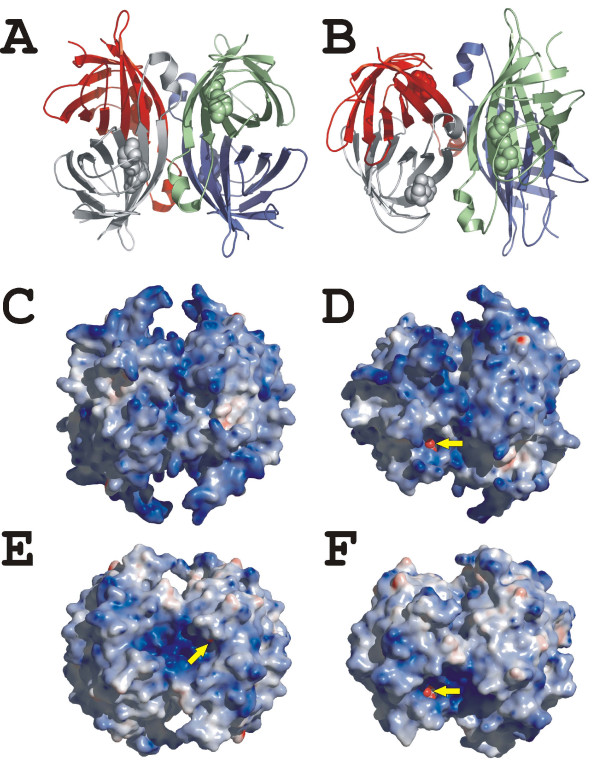
The overall X-ray structure of chicken BBP-A. (a, b) A tetrameric ribbon model of the BBP-A – BSO structure. (c, d) Electrostatic potentials mapped onto the molecular surface of the BBP-A – BSO structure. (e, f) Electrostatic potentials mapped onto the molecular surface of the AVD [PDB: 2AVI] [23] structure after superimposition on the BBP-A structure. The views shown in (a), (c) and (e) are rotated 45° around the X-axis in (b), (d) and (f). The BSO and BTN ligands of the BBP-A – BSO and AVD structures, respectively, are shown as spheres. The yellow arrows pinpoint visible parts of the valeric acid tails of BSO and BTN seen in (d), (e) and (f).